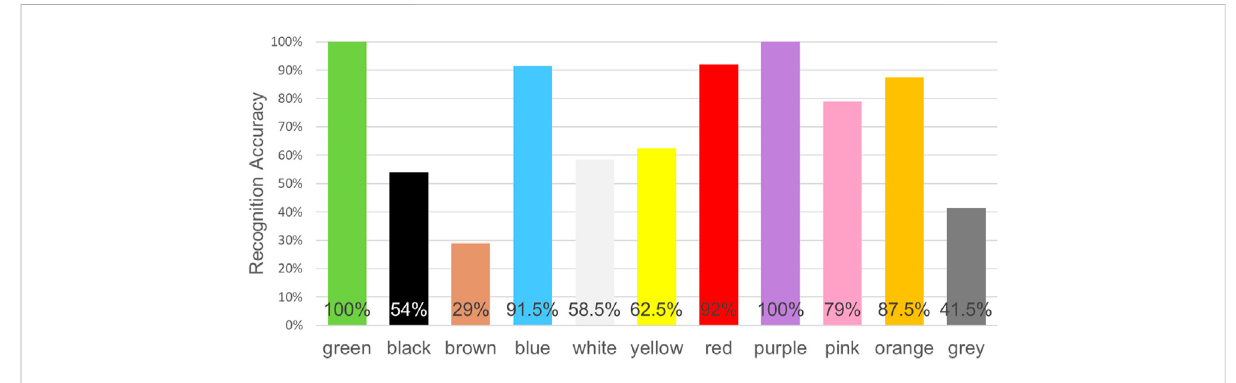
FIGURE 3 Recognition accuracy (in percentage) for each ambient color.